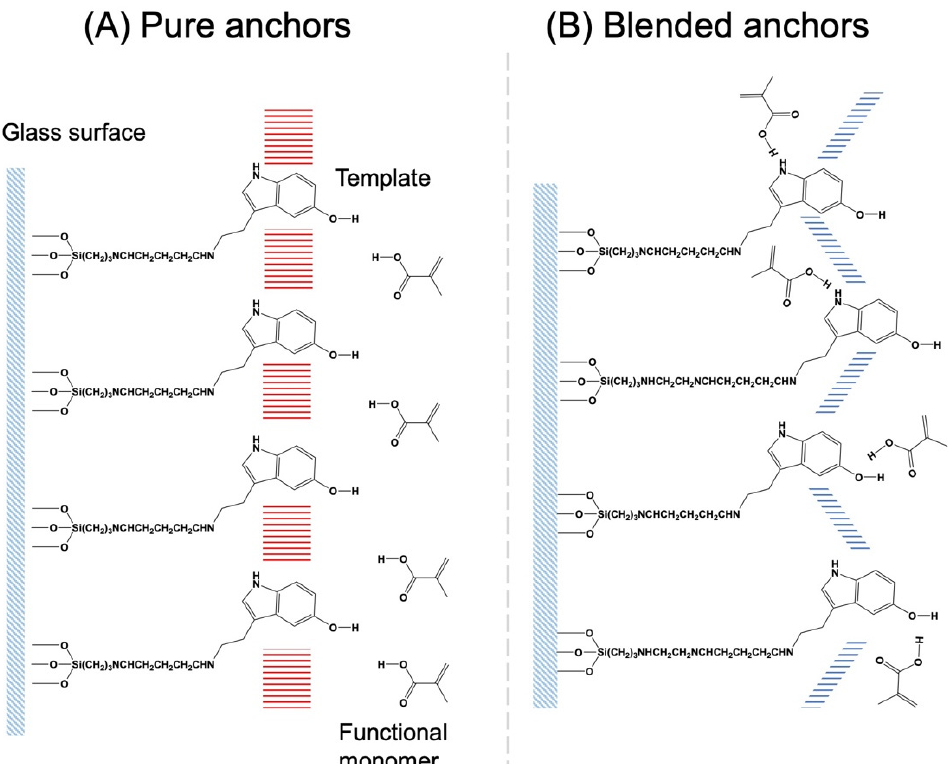
Figure 5. The templates anchored with the pure anchors have strong interactions with their neighbors, so the interaction with the functional monomer is weaker ( A ). However, the template anchored with the blended anchors have weaker interactions with their neighbors due to misalignment, so the interaction with the functional monomer is stronger ( B ).